Question: Write a caption explaining this figure to a reader.
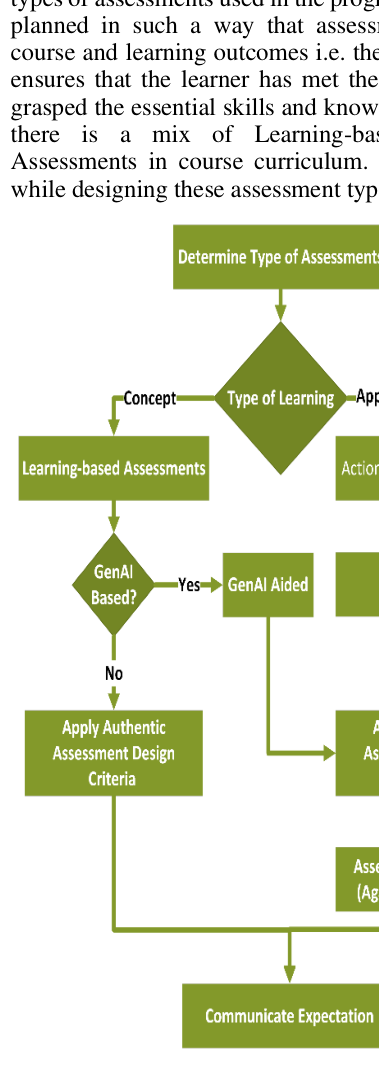
Answer: Proposed assessment design process.